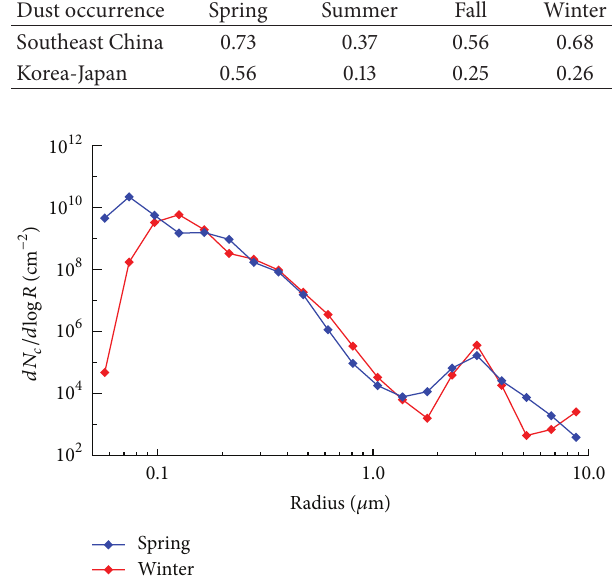
Figure 10: Particle size distribution of aerosols over Wuhan during the dust cases in spring and winter, derived from sun photometer data